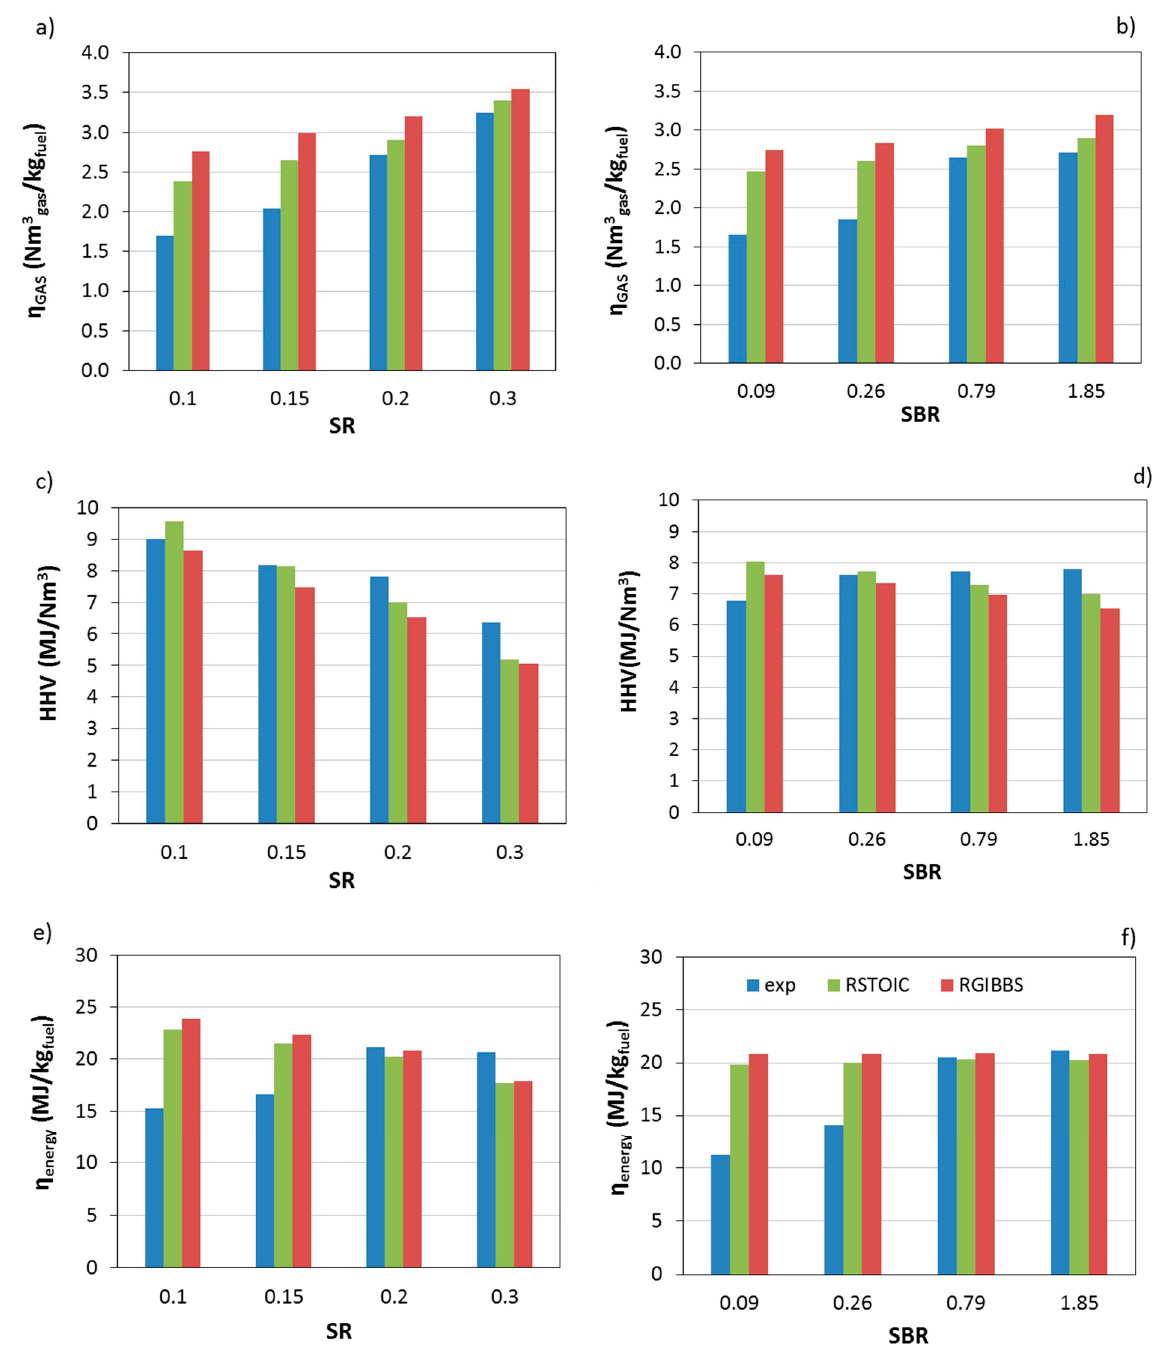
Figure 9. Effect of SR and SBR on η gas ( a , b ), HHV ( c , d ) and η energy ( e , f ) for the gasification of PKS at 900 ◦ C. Comparison of experimental results and predictions obtained with the non-stoichiometric and stoichiometric